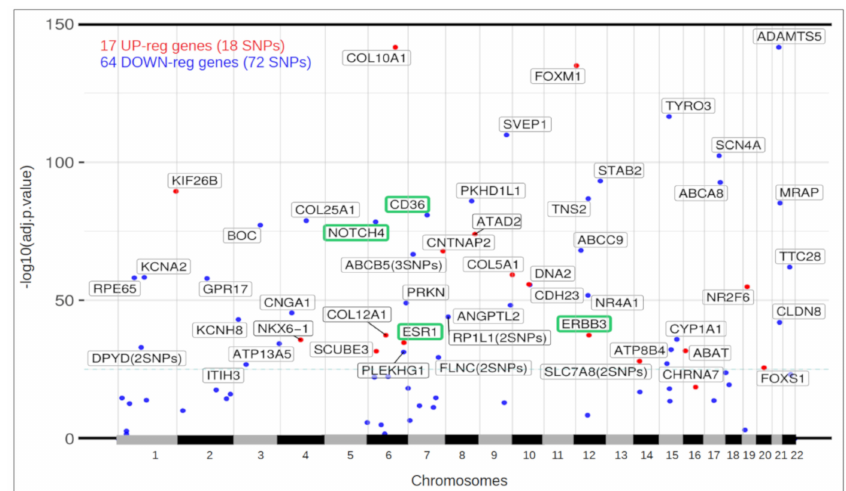
Figure 3. Plot of the chromosomal distribution (location) and di ff erential expression (significance) of 81 genes that presented highly pathogenic mutations and expression alterations in ductal luminal breast cancer (IDC-LM-BRCA)